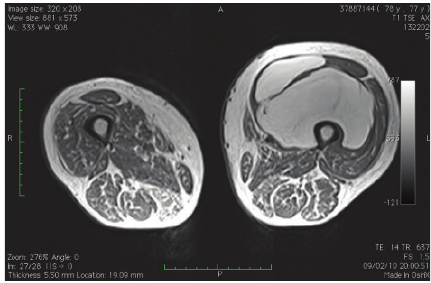
Figure 2: MRI of a lipomatous tumor in the anterior compartment of the thigh.